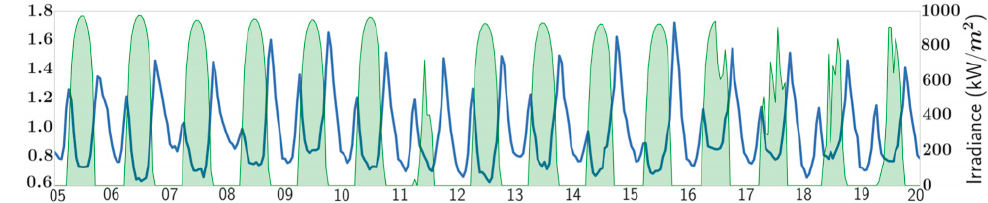
Figure 7. Typical solar irradiance energy price time-series of a solar thermal power plant. Reprint with permission [142]; 2018, Elsevier.